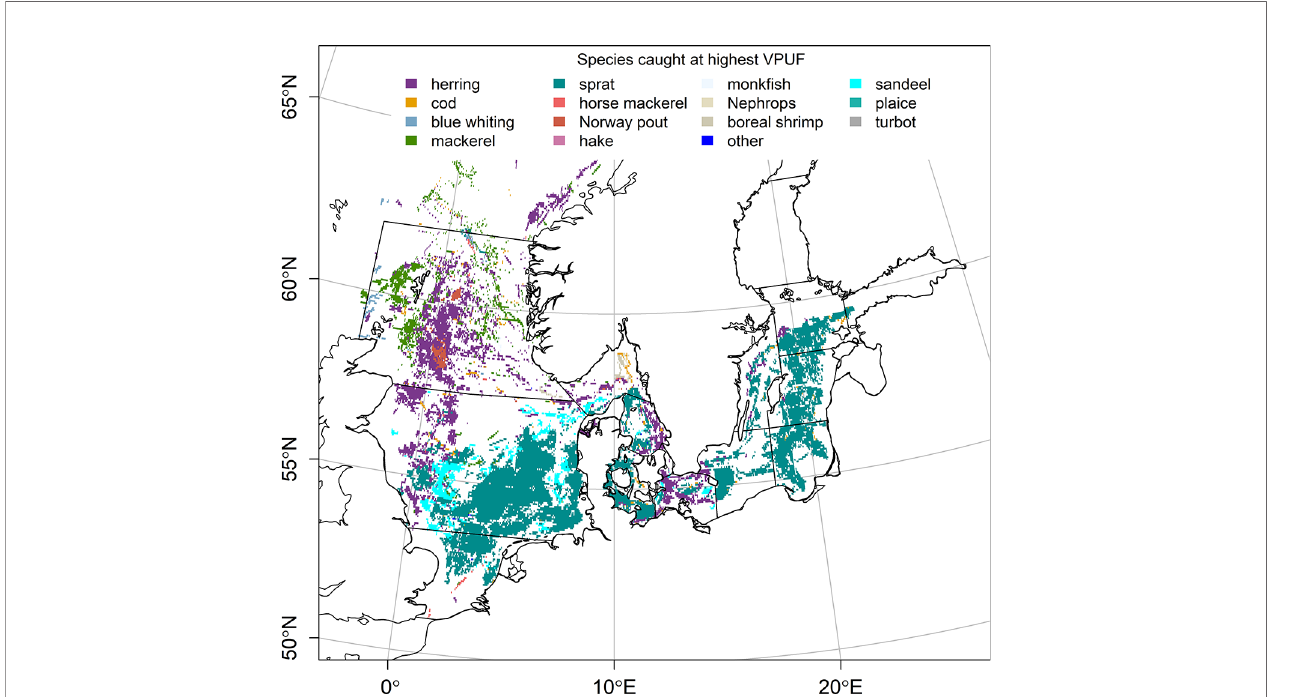
FIGURE 6 | Spatial distribution of the maximal value of indicators during 2005-2019 for landed species (i.e. colored per species) for pelagic gears deployed by Danish fl eets for vessels >12m (in FAO 22.3, 22.4 and part of 22.2) and aggregated on 1x1 minute grid